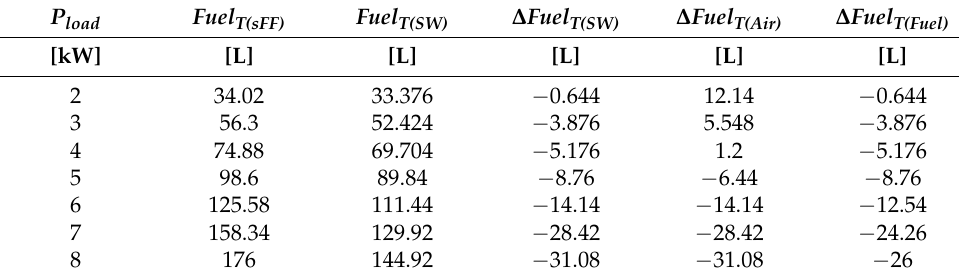
Table 2. Fuel economy for k fuel = 25.